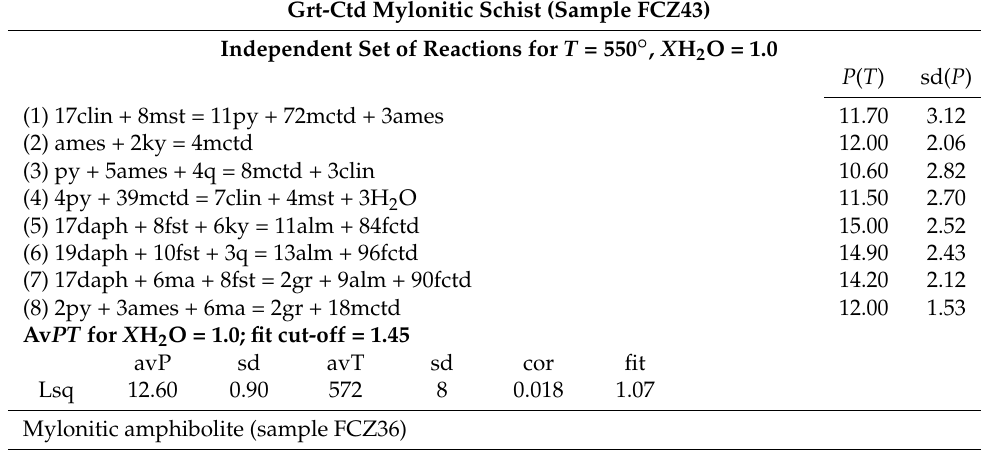
Table 5. Independent set of reactions calculated with THERMOCALC for a reference T and condensed av PT results for selected mylonitic samples. Abbreviations after [46]. Grt-Ctd Mylonitic Schist (Sample FCZ43) Independent Set of Reactions for T = 550 ◦ , X H 2 O =